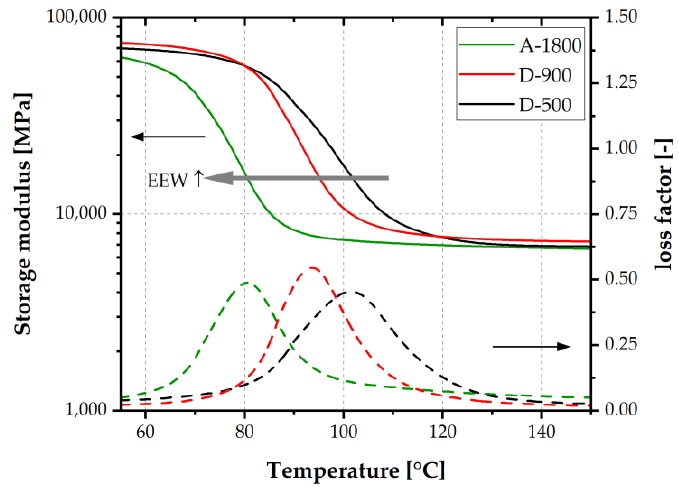
Figure 7. Storage modulus and loss factor curves of electrical steel laminates adhesively bonded with epoxy varnishes with EEW values of 500, 900 and 1800 g/mol.